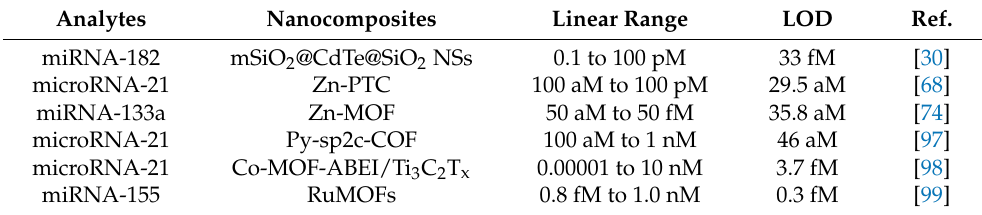
Table 5. Summary of the construction of ECL biosensors based on porous nanocomposites for nucleic acids